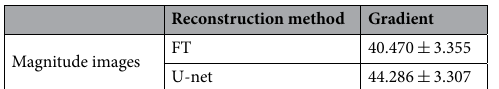
Table 3. Results of prospectively acquired MR